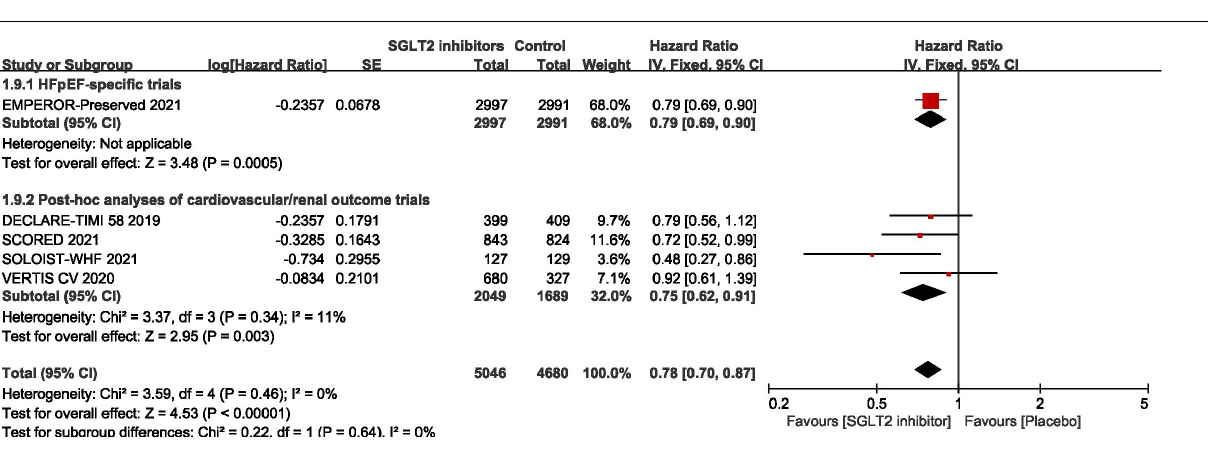
FIGURE 5 | Forest plot displaying the results of subgroup analysis by types of studies.